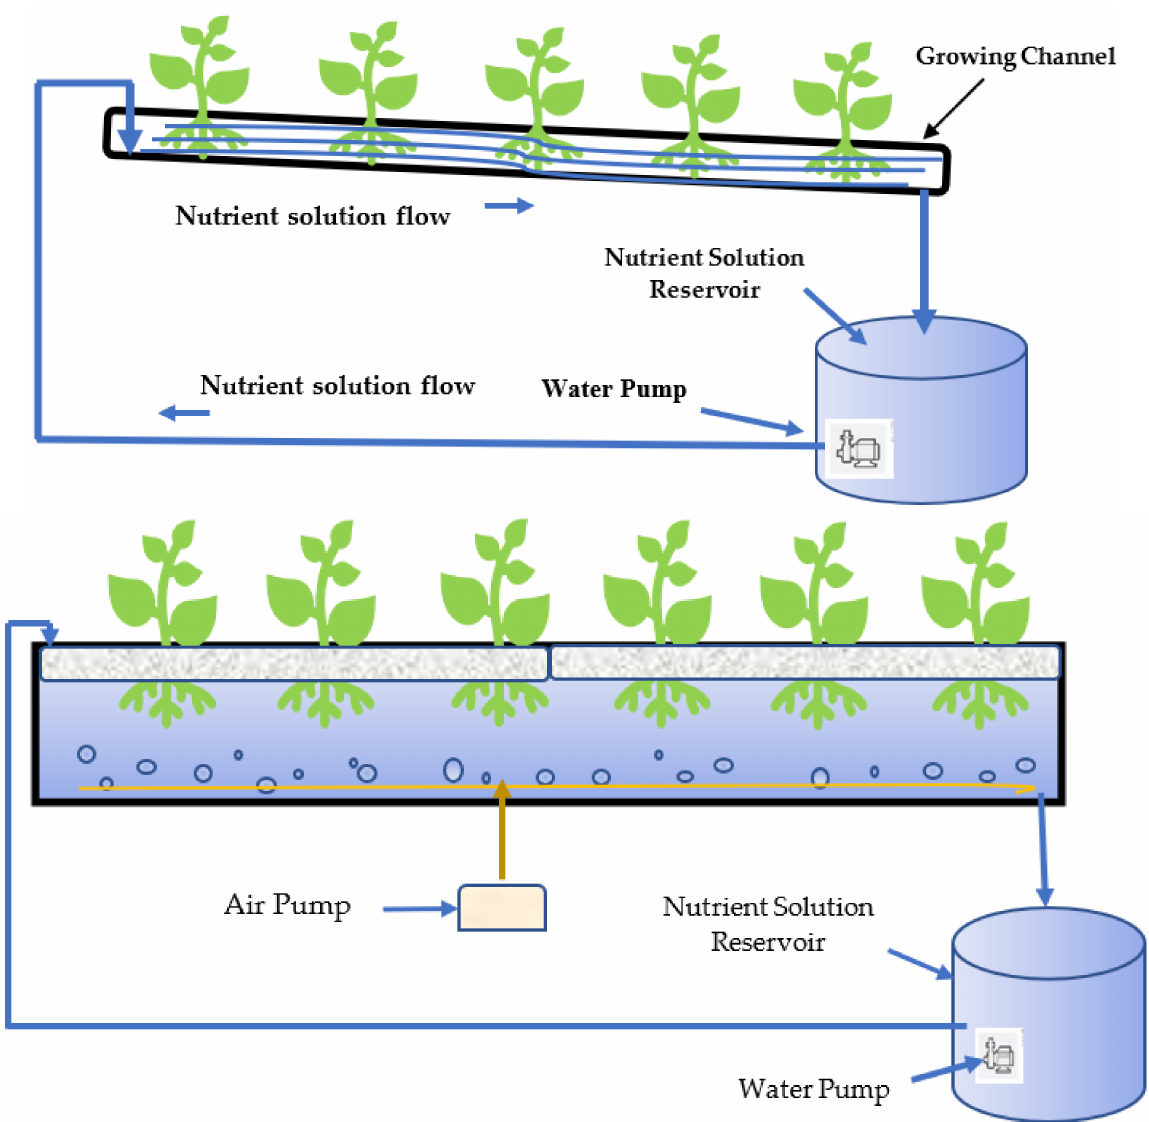
Figure 1. Schematic diagram of Nutrient Film Technique (NFT, top ) and deep-water culture (DWC, bottom ) hydroponic